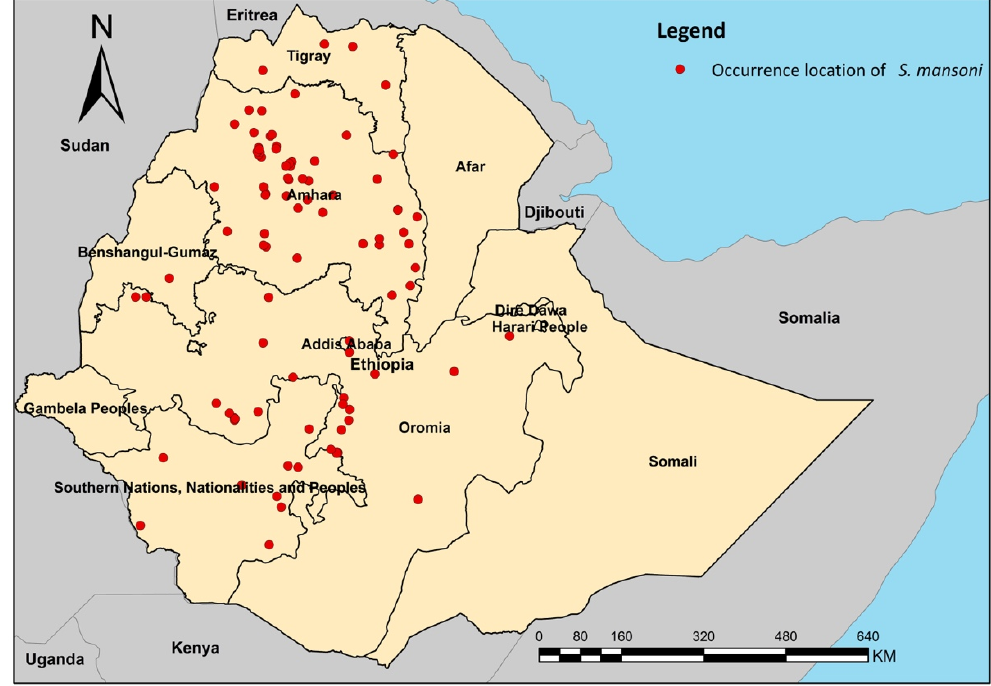
Figure 1. Occurrence locations of S. mansoni endemic areas derived from 62 surveys in Ethiopia.